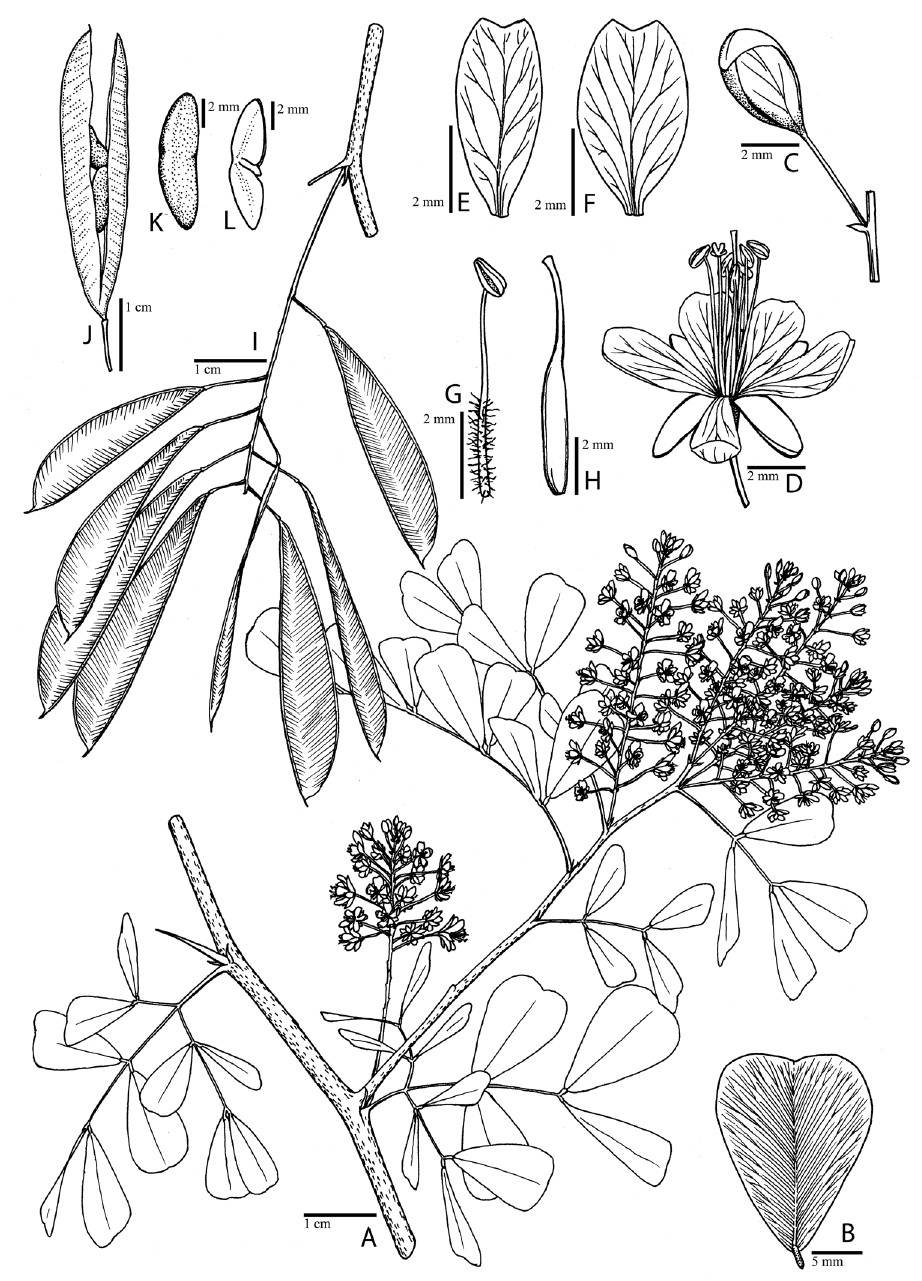
Figure 7. Haematoxylum campechianum L . A flowering branch B leaflet C flower bud D flower E me- dian petal F lateral petal G stamen H gynoecium I infructescence J dehiscing fruit K seed L embryo. A, B, D–H from Lorence 2746 C from Balfour s.n. I–L from Johnston s.n. Drawn by Eleanor Catherine, originally published in Flore des Mascareignes 80. Légumineuses , page 6, plate